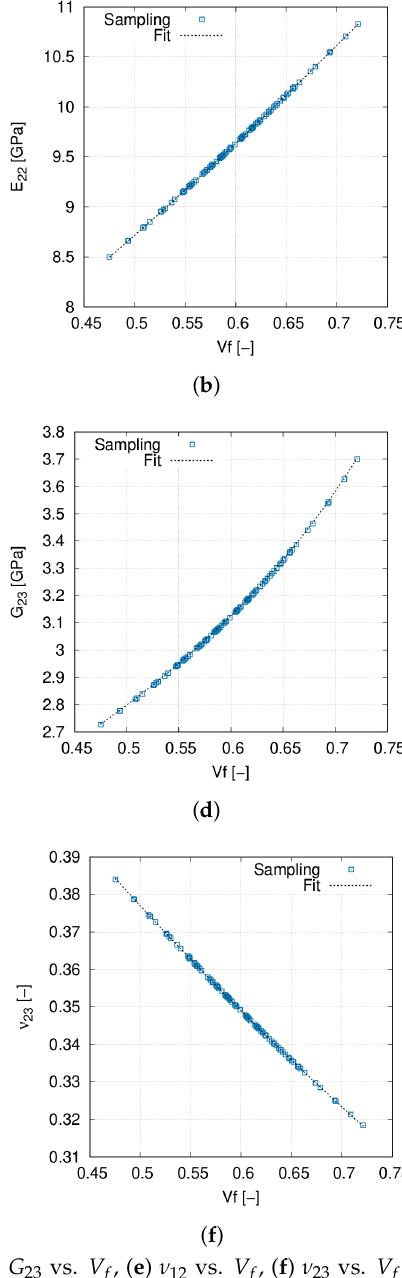
Figure 9. ( a ) E 11 vs. V f , ( b ) E 22 vs. V f , ( c ) G 12 vs. V f , ( d ) G 23 vs. V f , ( e ) ν 12 vs. V f , ( f ) ν 23 vs. V f . Sampling results and data fit of the homogenised material properties. Fibre volume fraction is treated as a Gaussian random variable with mean value V f = 0.60 and standard deviation σ V